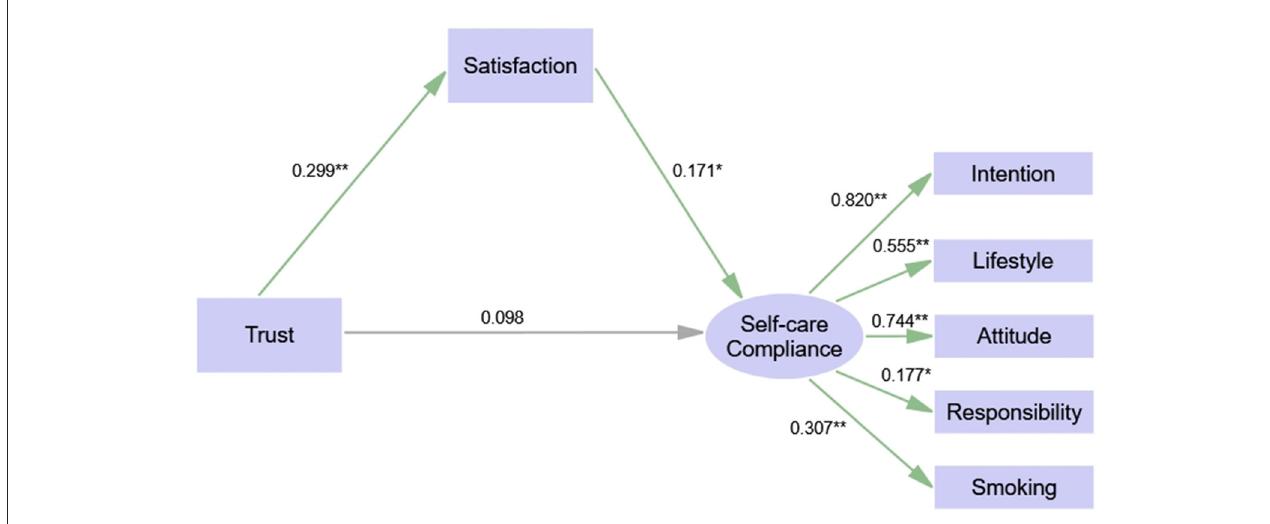
FIGURE3 Structural equation model of trust, satisfaction and compliance (sub-sample: male). Significant codes: ** P < 0.01; * P < 0.05.